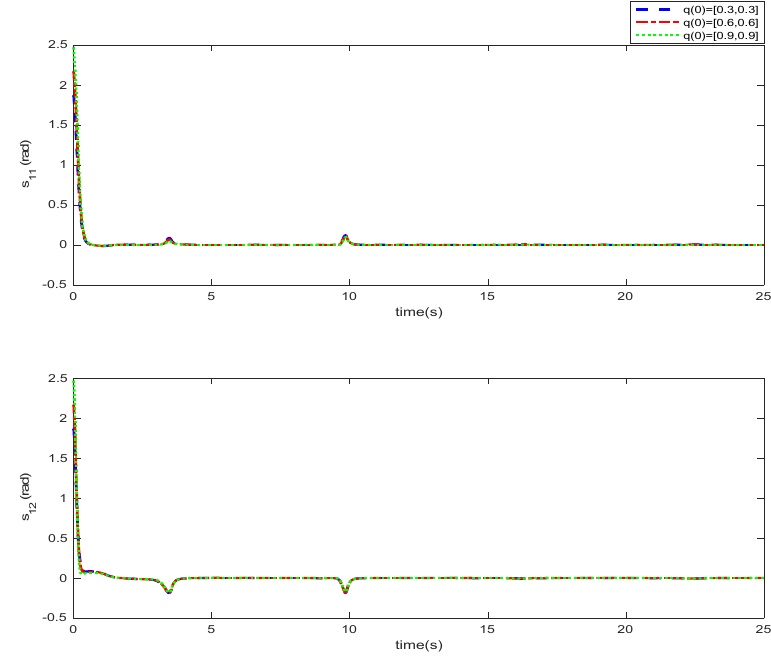
Figure 10. Sliding surface in Scenario 2.